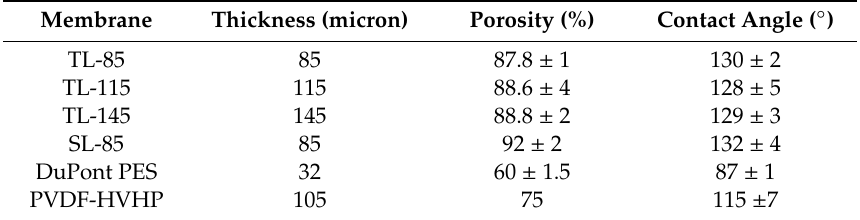
Table 1. Properties of membranes used in this